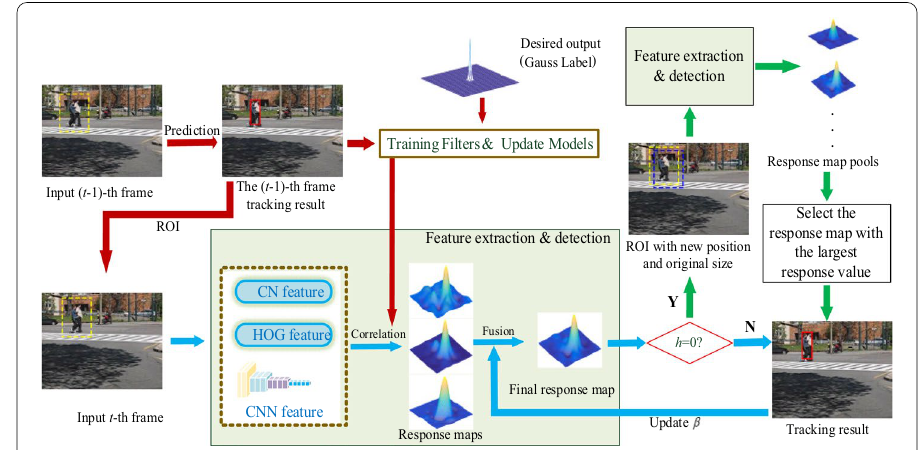
Fig. 1 Procedure of the proposed